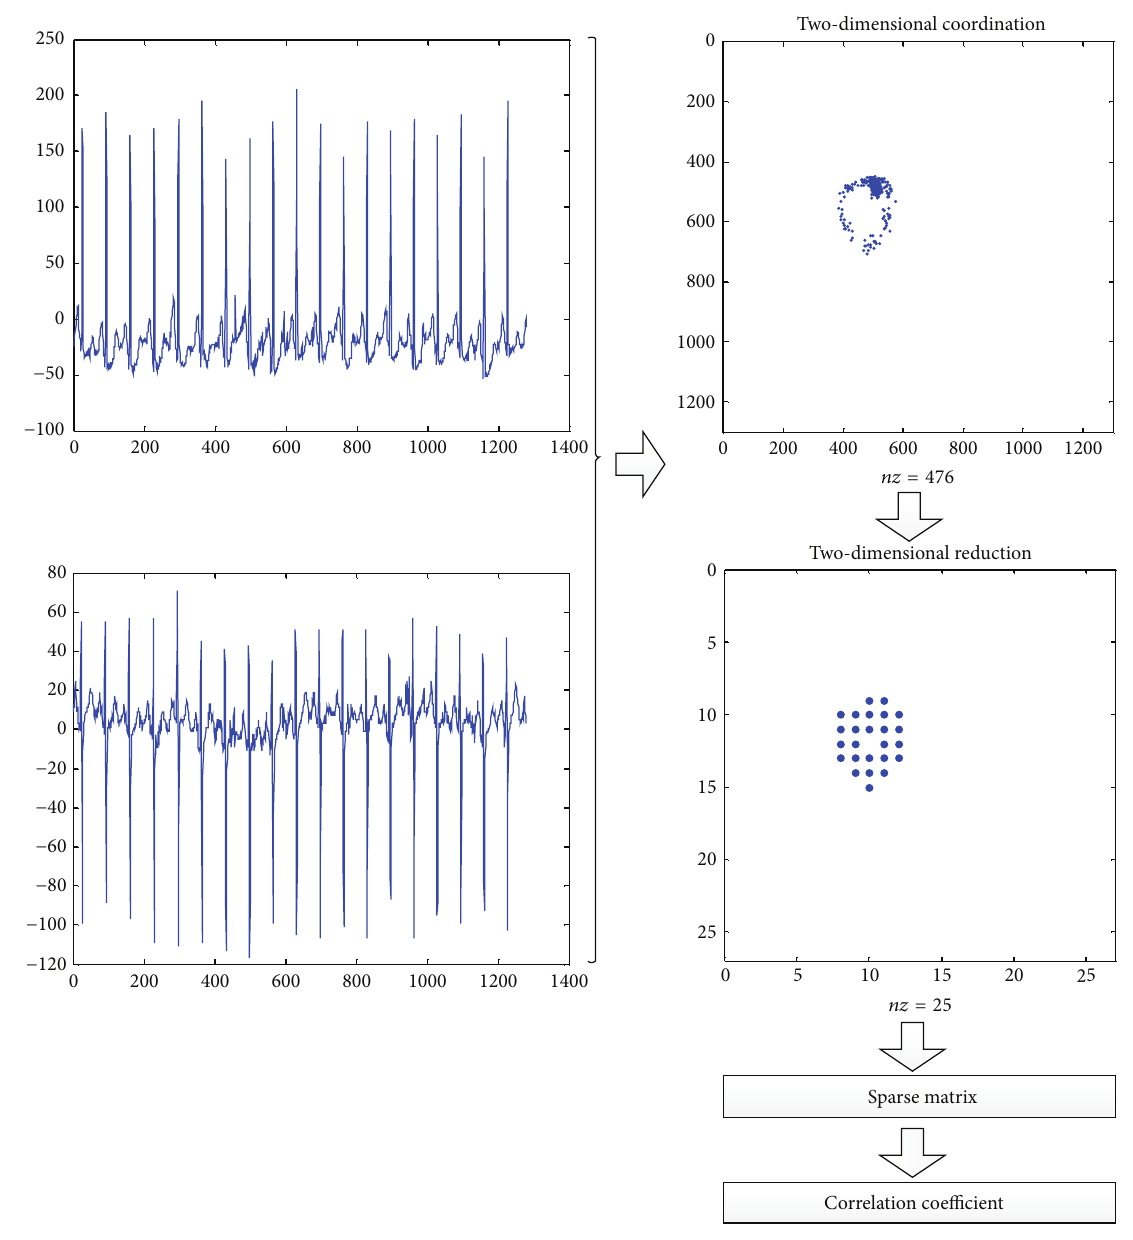
Figure 1: Procedure of ECG identification system with sparse